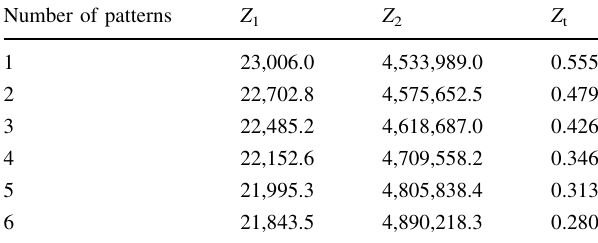
Table 11 Sensitivity analysis of the number of patterns Number of patterns